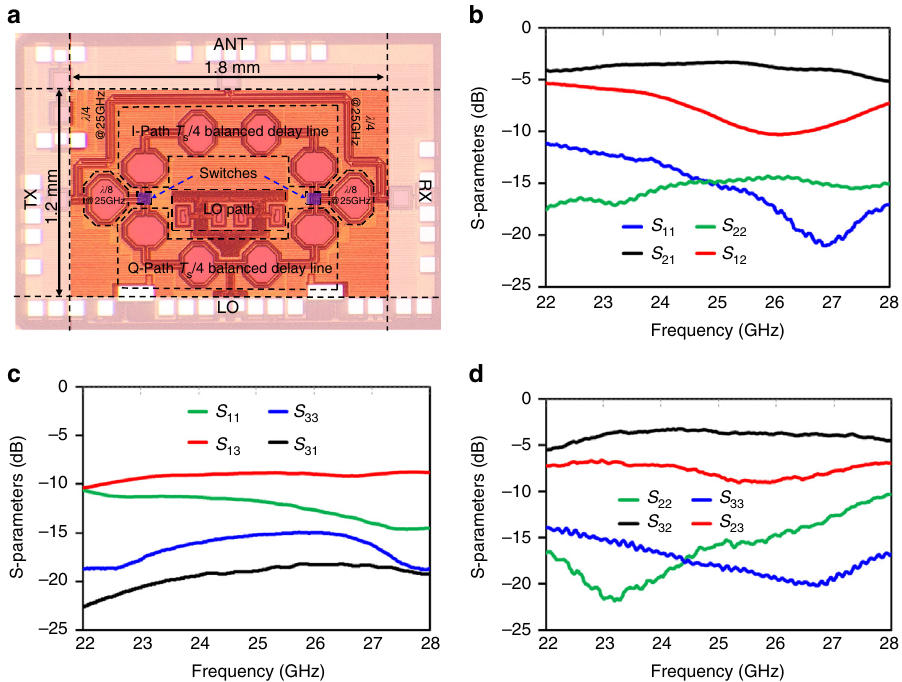
Fig. 5 25 GHz 45 nm SOI CMOS circulator S-parameter measurements. a Microphotograph of the fabricated circulator. The total size of the 25 GHz circulator is 1.2 mm × 1.8 mm. Measured S-parameters for 8.33 GHz spatiotemporal conductivity modulation between b ports 1 and 2, c ports 1 and 3, and d ports 2 and 3. Low-loss transmission in the clockwise direction ( S 21 , S 32 , and S 13 are − 3.3 dB, − 3.2 dB, and − 8.7 dB, respectively) and large isolation in the reverse direction ( S 12 , S 23 and S 31 are − 10.3 dB, − 9 dB, and − 18.9 dB, respectively) are measured at the operation frequency of 25 GHz. A broadband isolation of − 18.3 to − 20.2 dB (limited by the measurement setup) in S 31 is demonstrated over 4.6 GHz bandwidth (the 1 dB insertion loss bandwidth in S 21 and S 32 ) without any port impedance tuning